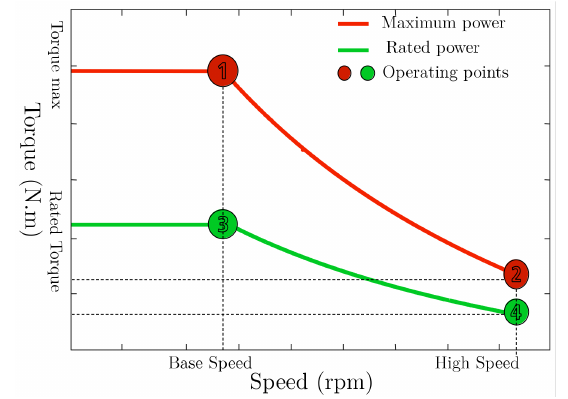
Figure 15. Electric motor torque-speed